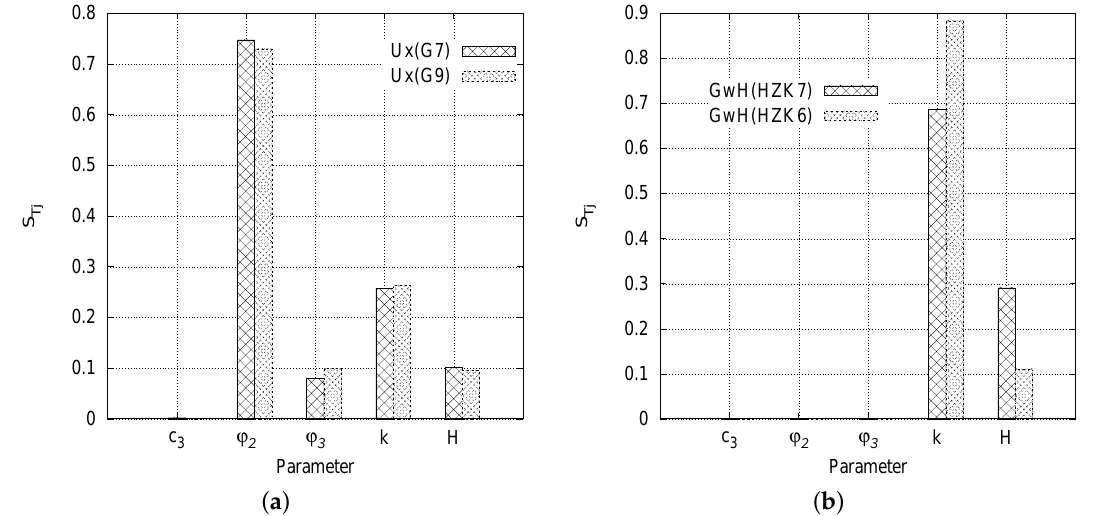
Figure 10. GSA results for: ( a ) horizontal displacements at G7 and G9, ( b ) groundwater level at HZK6 and